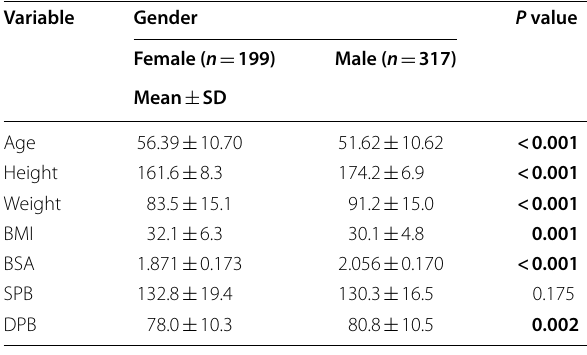
Bold mean significant values that is less than or equal 0.05